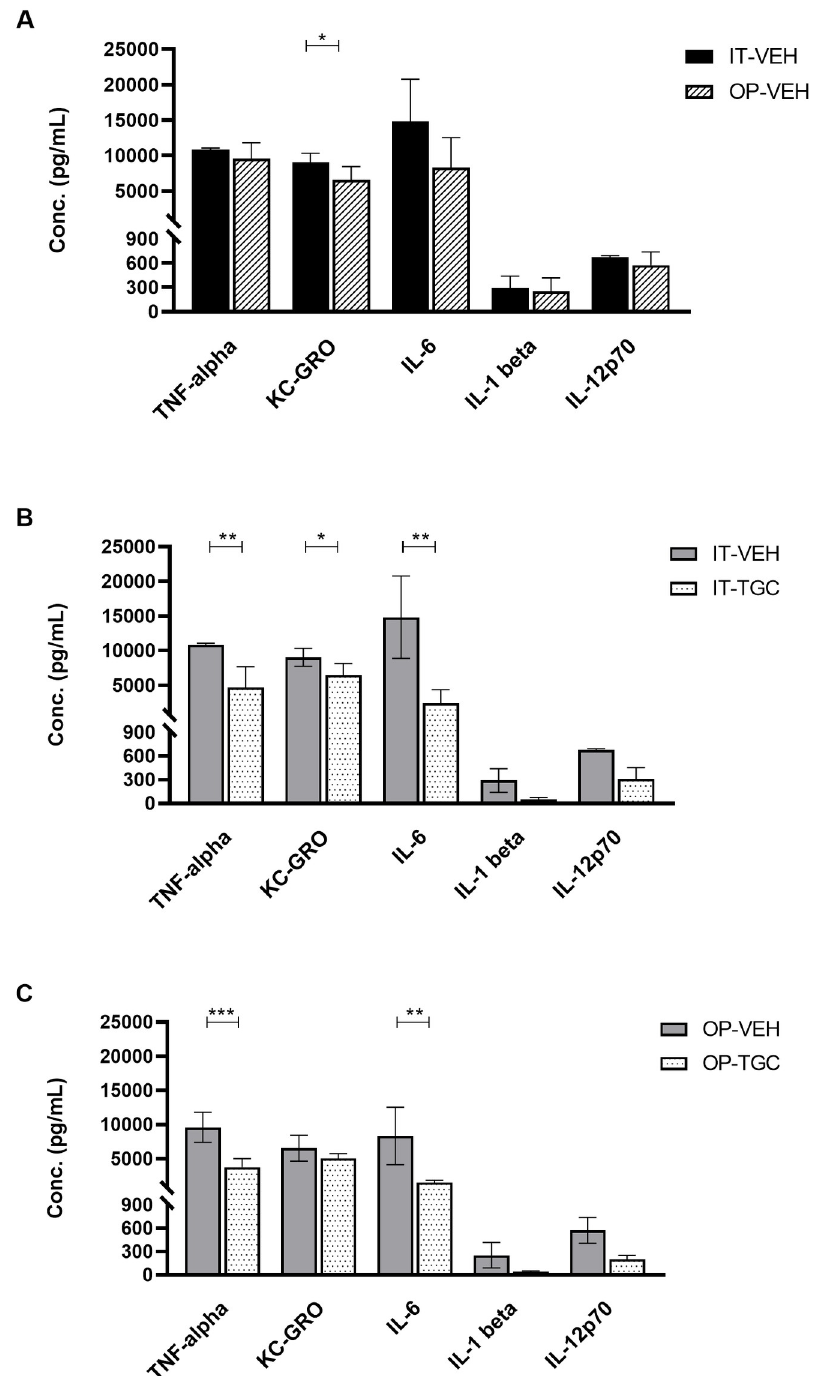
Fig 4. Cytokine quantification in BALF of A . baumannii ACC001 infected mice. Lung BALF cytokine quantification in vehicle (VEH) treated infected mice to assess the role played by the route of the infection intratracheal vs oropharyngeal (IT vs OP) (A) and to compare the effect of the tigecycline vs vehicle (TGC vs VEH) on the establishment of the innate immune response in intratracheally (IT) and oropharyngeally (OP) infected mice (B and C). Data expressed as mean ± SD. Statistical analysis was performed by two tailed Student’s T test considering significant p � 0.05.